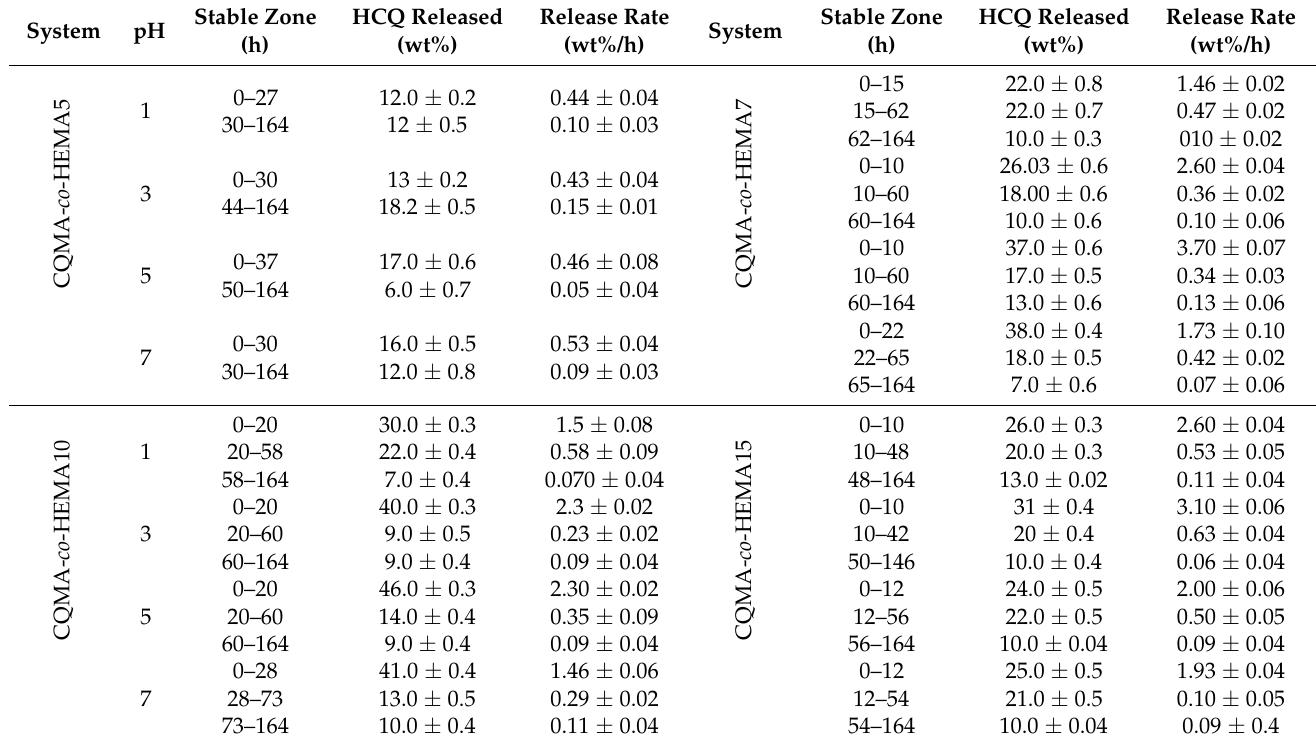
Table 6. Performance of the CQMA- co -HEMA drug carrier